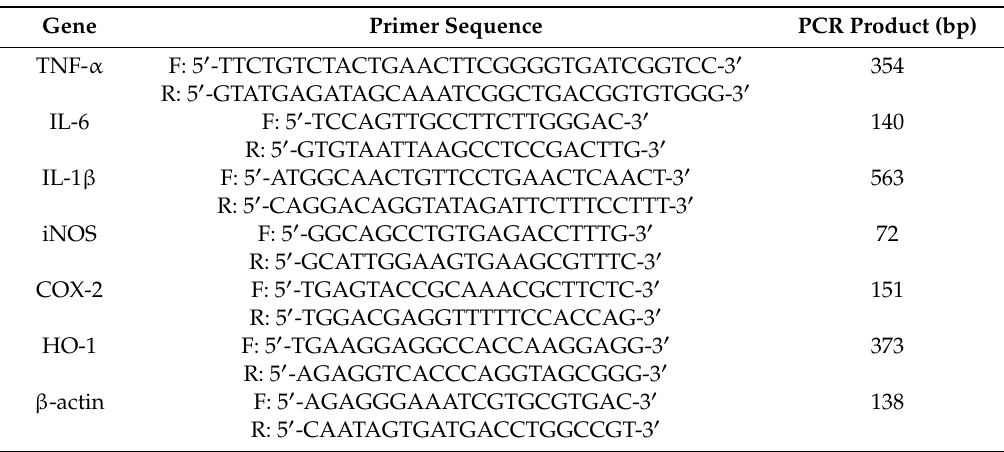
Table 3. Primers used for